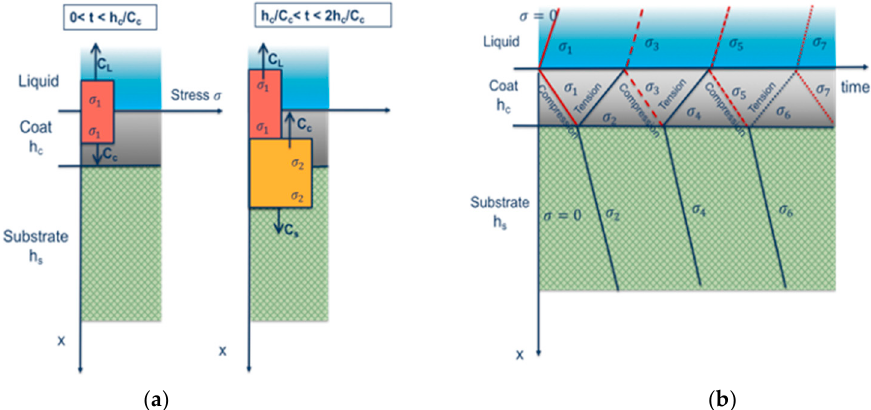
Figure 6. Stress wave pattern in the coating and in the substrate for the time intervals related with coating thickness h c and its wave speed Cc. ( a ) Stress wave contact at interface; ( b ) Stress wave consecutive interactions.